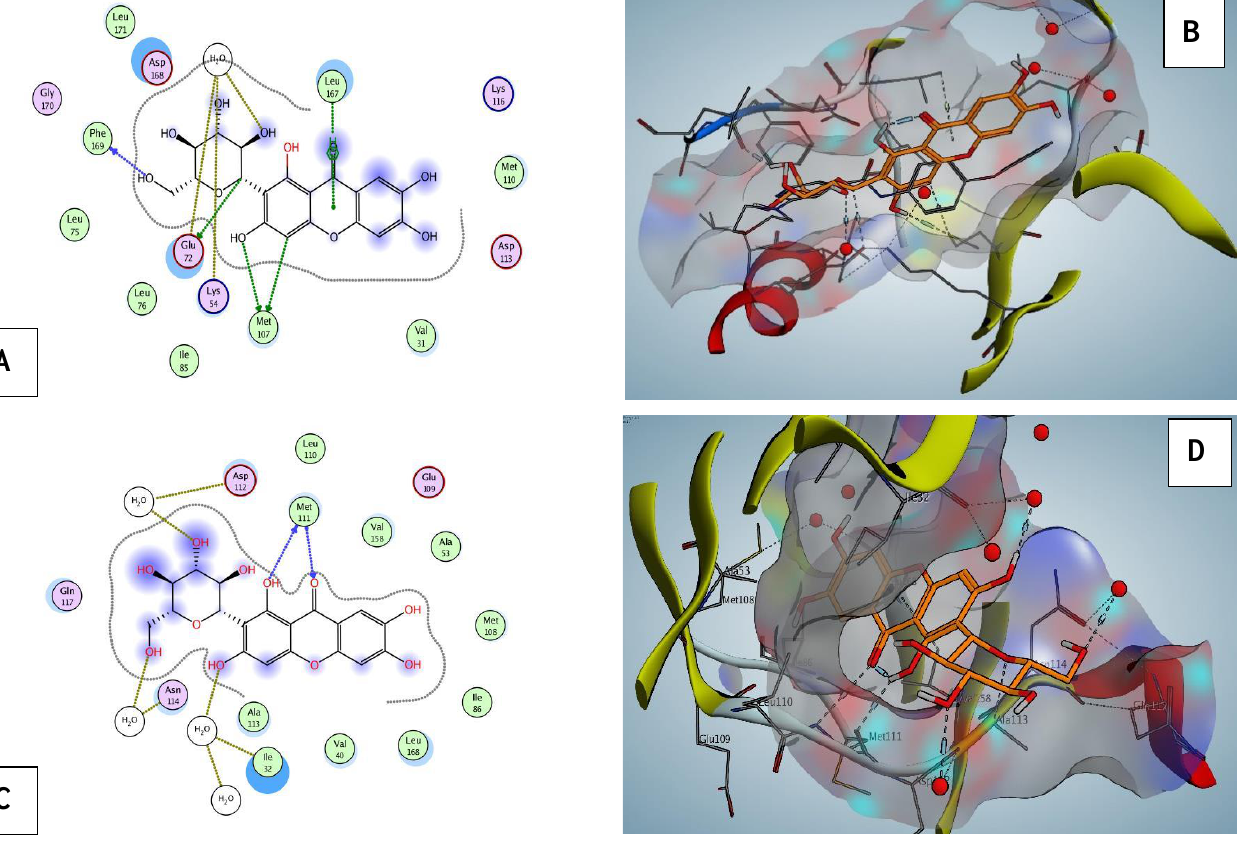
Figure 11. MAPK 13 (p38-delta) (PDB: 4EYM) and JNK1 (PDB: 3ELJ) protiens, ( A , C ) 2D and ( B , D ) 3D diagrams respectively show the interaction of Mang (orange) in the binding pocket.